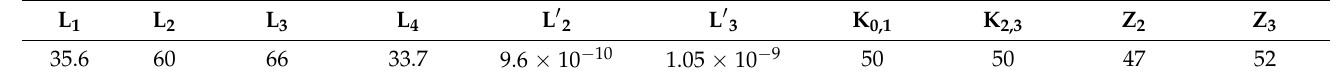
Table 5. Parameter values of the 10 GHz filter different elements from the synthesis.